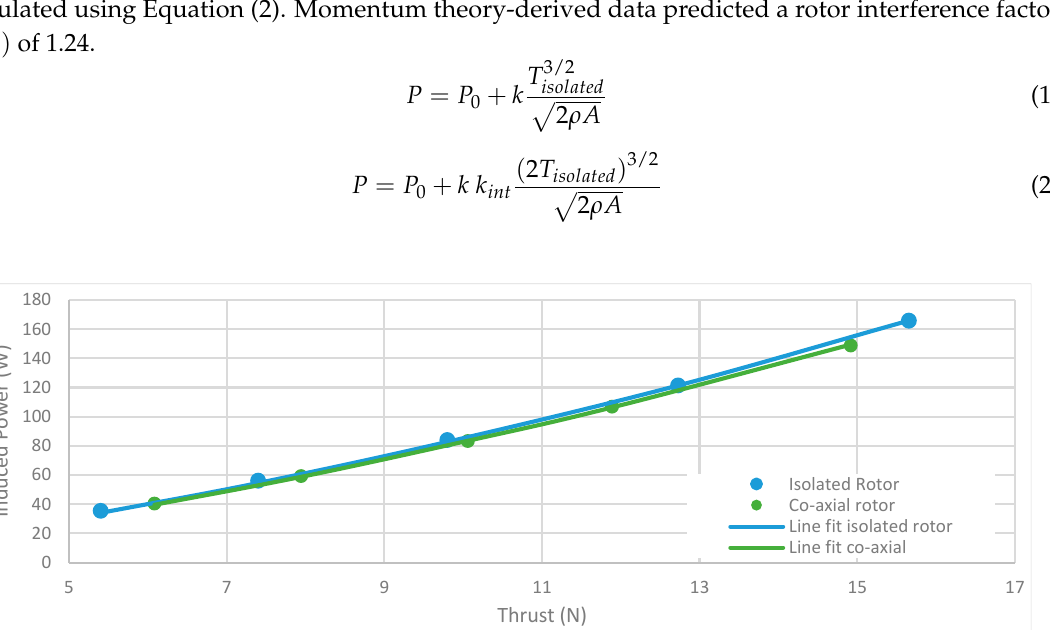
Figure 12. Performance analysis of an isolated rotor in comparison to a co-axial setup ( z / D = 0.1).